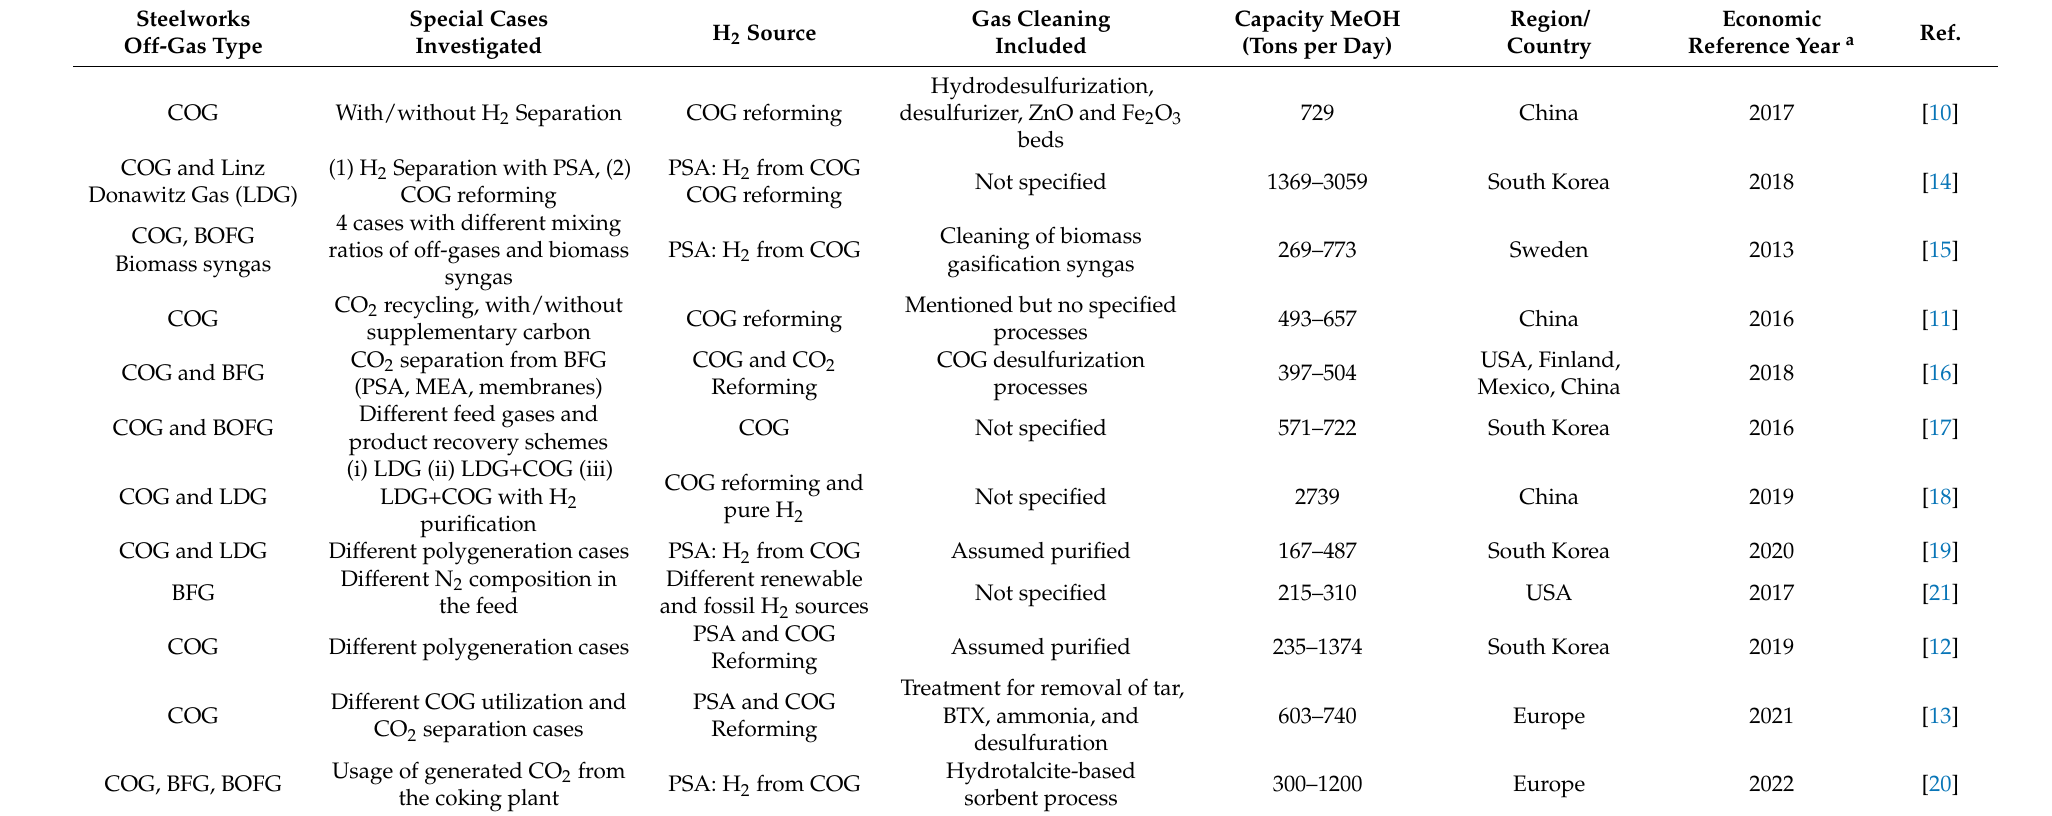
Table 1. Literature review of steelworks off-gases to methanol techno-economic analysis